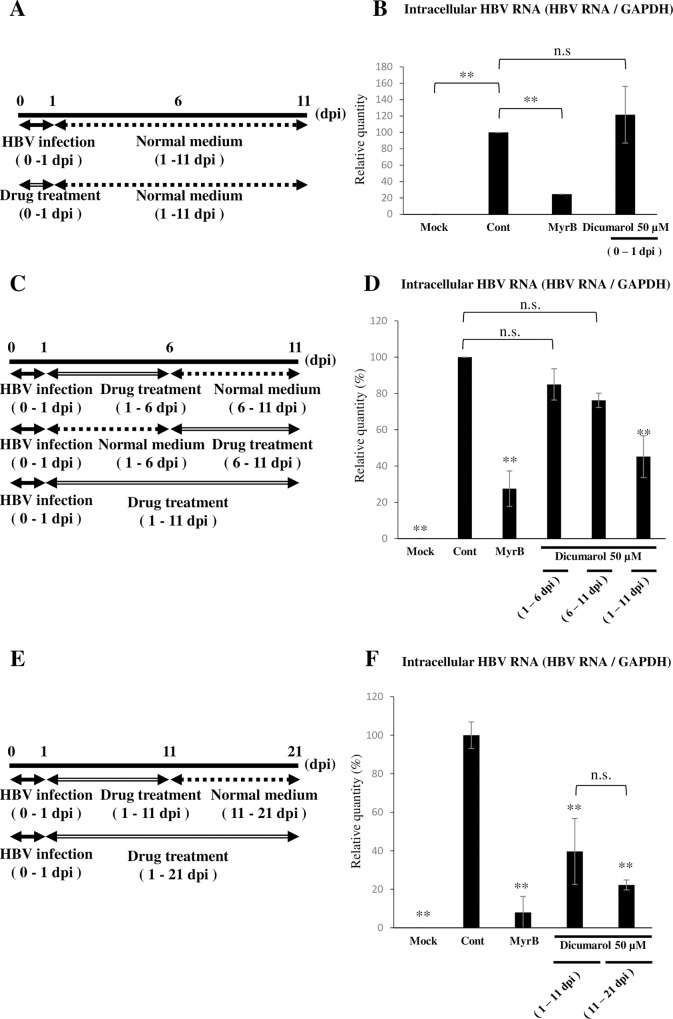
Dicumarol did not inhibit HBV adsorption/entry.NmcHepG2 cells were infected with HBV in the absence or presence of dicumarol or MyrB at 0–1 dpi (A). (B) At 11 dpi, total cell RNA was isolated and quantified for HBV RNA. Next, cells were treated with dicumarol during HBV replication, as shown in C. As a reference, cells were untreated (cont) or treated with MyrB during HBV adsorption/entry (MyrB). (D) At 11 dpi, RNA was extracted and quantified for HBV RNA. To evaluate the effects of dicumarol during long-term HBV infection (21 days), cells were infected and treated with HBV, as shown in E. (F) At 21 dpi, RNA was extracted. HBV RNA levels relative to the control HBV replication level are shown. Controls are as in D. Data are means ± SE of replicates from three independent experiments and were analyzed by the t-test: *P < 0.05, **P < 0.01.